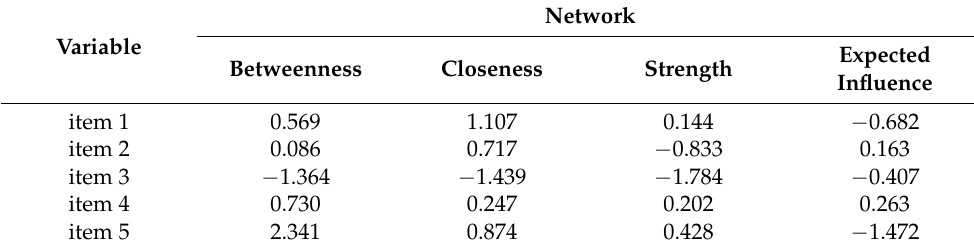
Figure 2. Network analysis and centrality plot for the 5 factors of the questionnaire. Table 2. Centrality measures for the items associated with the 5 factors.